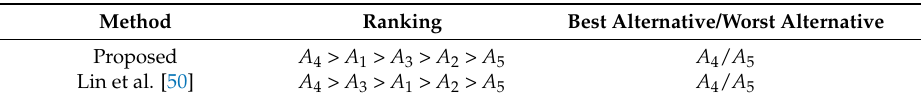
Table 16. Comparison of ranking of alternatives.